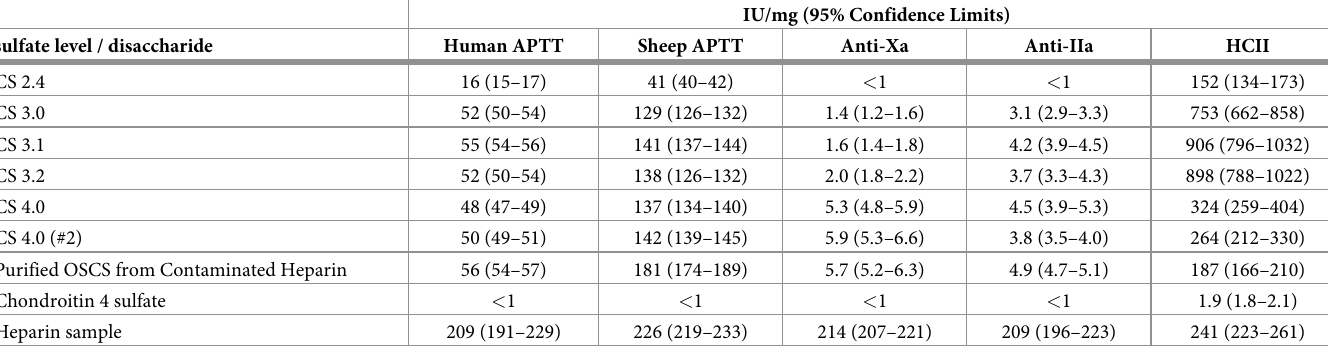
Table 3. Anticoagulant activities of chemically sulfated CSs and purified OSCS from contaminated heparin.